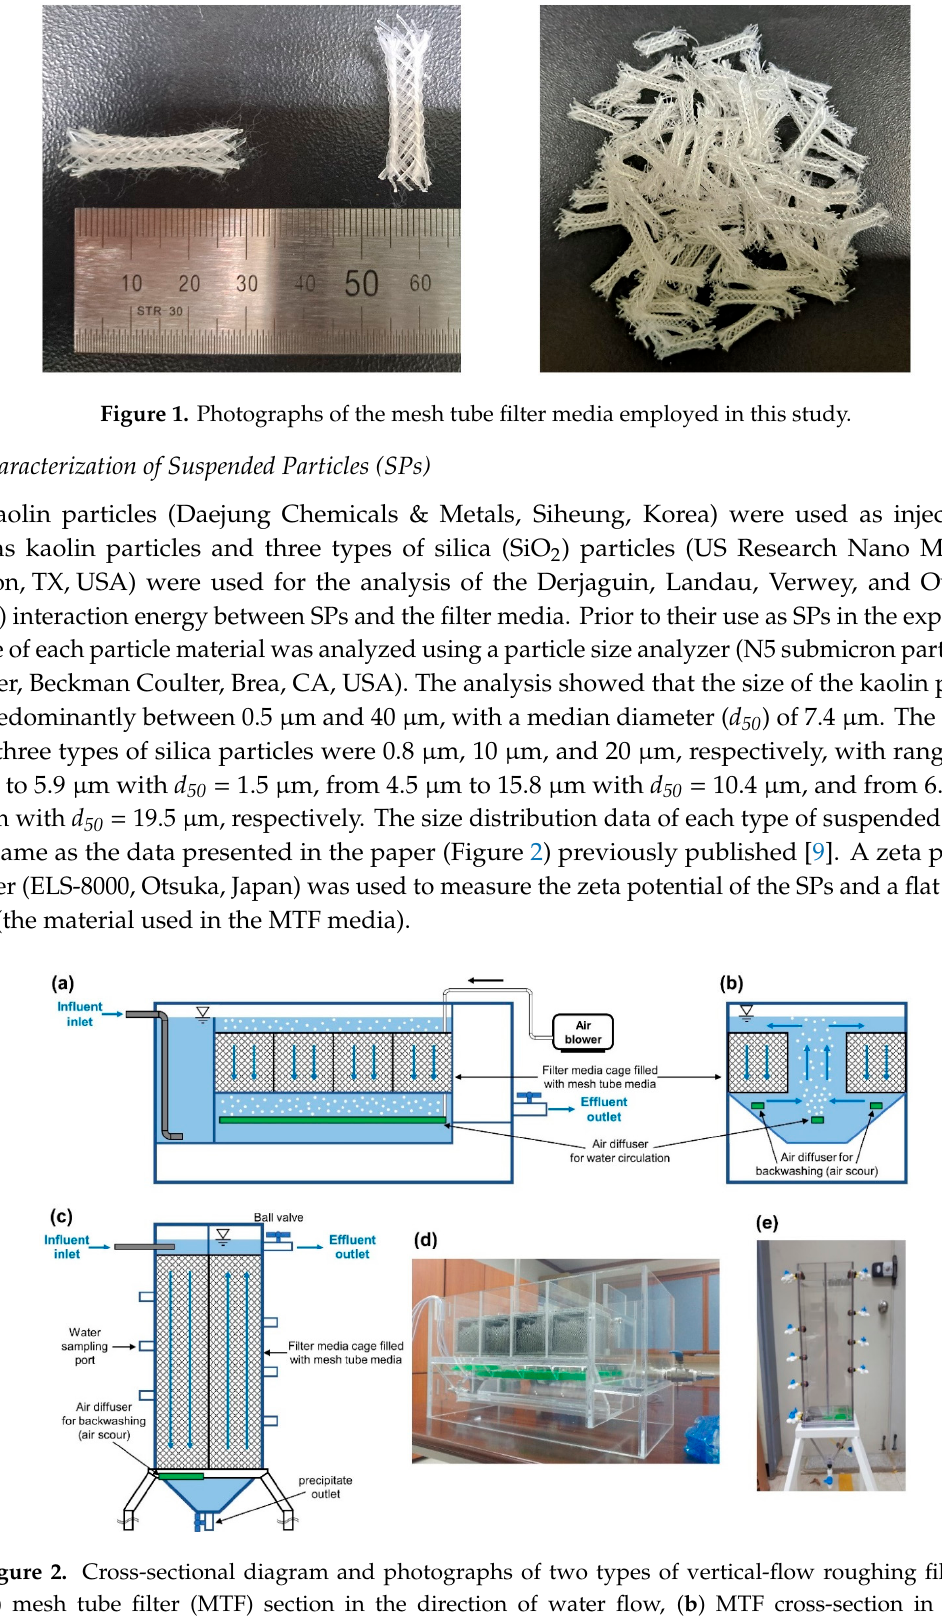
Figure 2. Cross-sectional diagram and photographs of two types of vertical-flow roughing filter: ( a ) mesh tube filter (MTF) section in the direction of water flow, ( b ) MTF cross-section in the direction perpendicular to water flow, ( c ) porous filter bed (PFB) section in the direction of water flow, ( d ) photograph of MTF reactor, ( e ) photograph of PFB reactor.